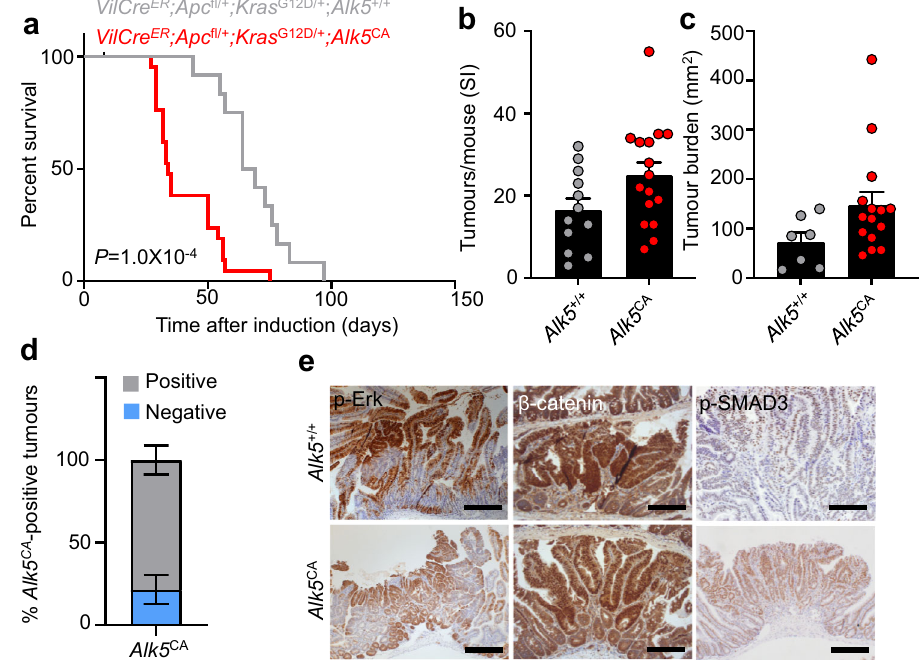
Fig. 4 | Epithelial TGF β /ALK5 signalling synergises with Wnt and MAPK signalling to accelerate tumourigenesis. a Survival plot for VilCre ER ;Apc fl /+ ; Kras G12D/+ ;Alk5 +/+ ( n =12, grey) and VilCre ER ;Apc fl /+ ;Kras G12D/+ ;Alk5 CA ( n =22, red) mice aged until clinical endpoint following tamoxifen induction. P =1.0×10 − 4 , log-rank test. b , c Small intestinal (SI) tumour number ( b ) and burden ( c ) per mouse from mice described in a . n =12 Alk5 +/+ mice (grey), n =16 Alk5 CA mice (red) for tumour number dataset; n =7 Alk5 +/+ mice (grey), n =15 Alk5 CA mice (red) for tumour